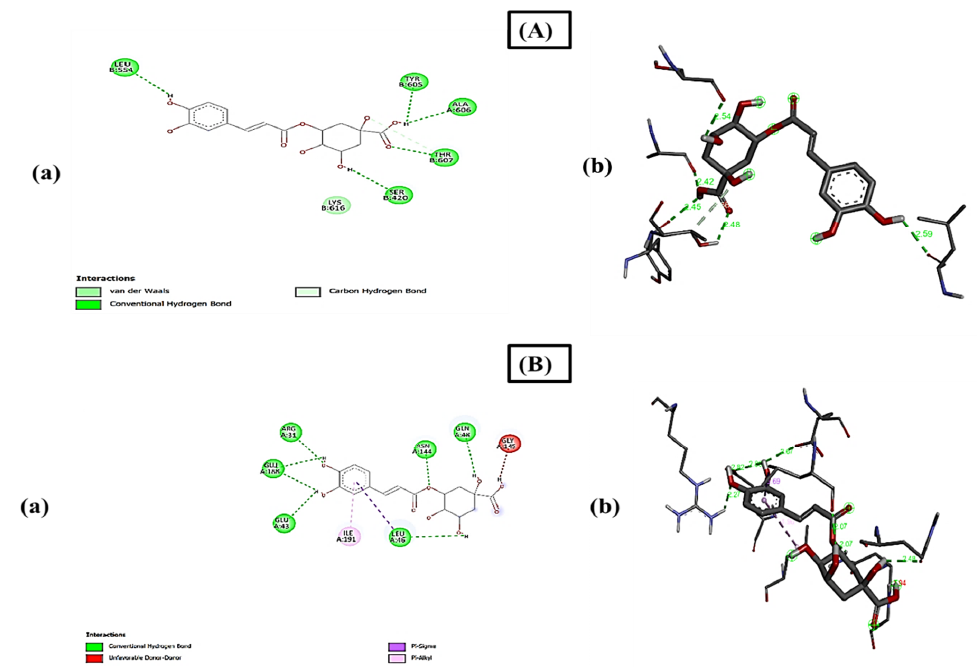
Figure 13. Molecular interactions. ( A ) Chlorogenic acid and ABCG2 (−8). ( a ) Two-dimensional image of docked complex. ( b ) Three-dimensional image of docked complex. ( B ) Chlorogenic acid and Muthy (−8.8). ( a ) Two-dimensional image of docked complex. ( b ) Three-dimensional image of docked complex.